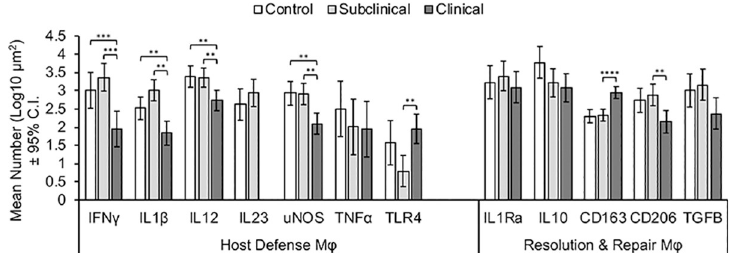
Fig 2. Mean number (Log μ m 2 ) of macrophages (AM-3K) classified as host defense (IFN- γ , IL-1 β , IL-12, IL-23, uNOS, TNF- α , and TLR4) or regulation of inflammation (IL-1Ra, IL-10m CD163, CD206, and TGF- β ), present in frozen bovine mid-ileal tissue sections collected from cows naturally infected with Mycobacterium avium subsp. paratuberculosis (subclinical and clinical), compared to uninfected control cows. Asterisks denote statistical significance: � p < 0.05; �� p < 0.01; ��� p < 0.001; ���� p < 0.0001.